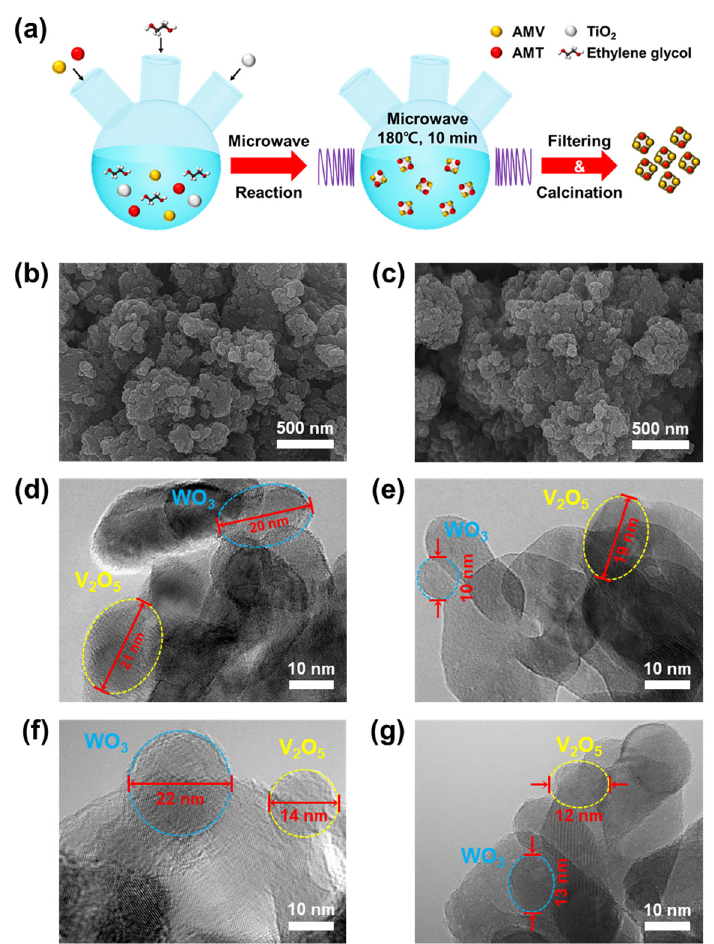
Figure 1. ( a ) Schematic of the polyol process on V 2 O 5 –WO 3 /TiO 2 catalysts using a microwave at 180 °C for 10 min. Field emission scanning electron microscope images of ( b ) V 2 O 5 (IM)–WO 3 (IM) and ( c ) V 2 O 5 (P)–WO 3 (P). Transmission electron microscope images of ( d ) V 2 O 5 (IM)–WO 3 (IM), ( e ) V 2 O 5 (IM)–WO 3 (P), ( f ) V 2 O 5 (P)–WO 3 (IM), and ( g ) V 2 O 5 (P)–WO 3 (P).